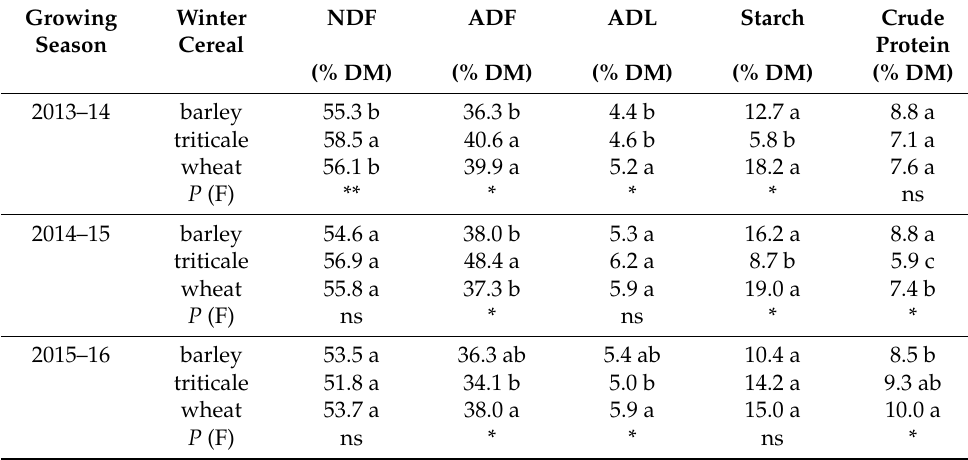
Table 5. Biomass composition of the three winter cereals 1